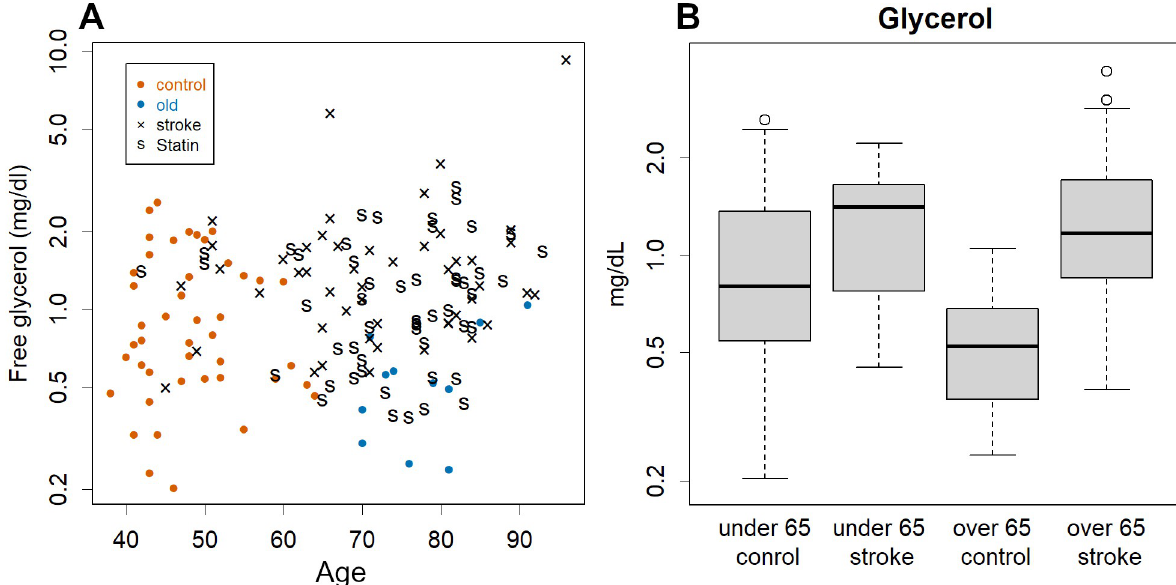
Fig 3. Glycerol levels and age. A . scatter plot; note the good separation between patients and controls. B . Box plot of free glycerol. There is a clear difference at least for those over 65 years of age. Free glycerol presumably depends on the rate of TG degradation, which occurs while storing or consuming fatty acids; the high level suggests that they rely much on lipids as an energy